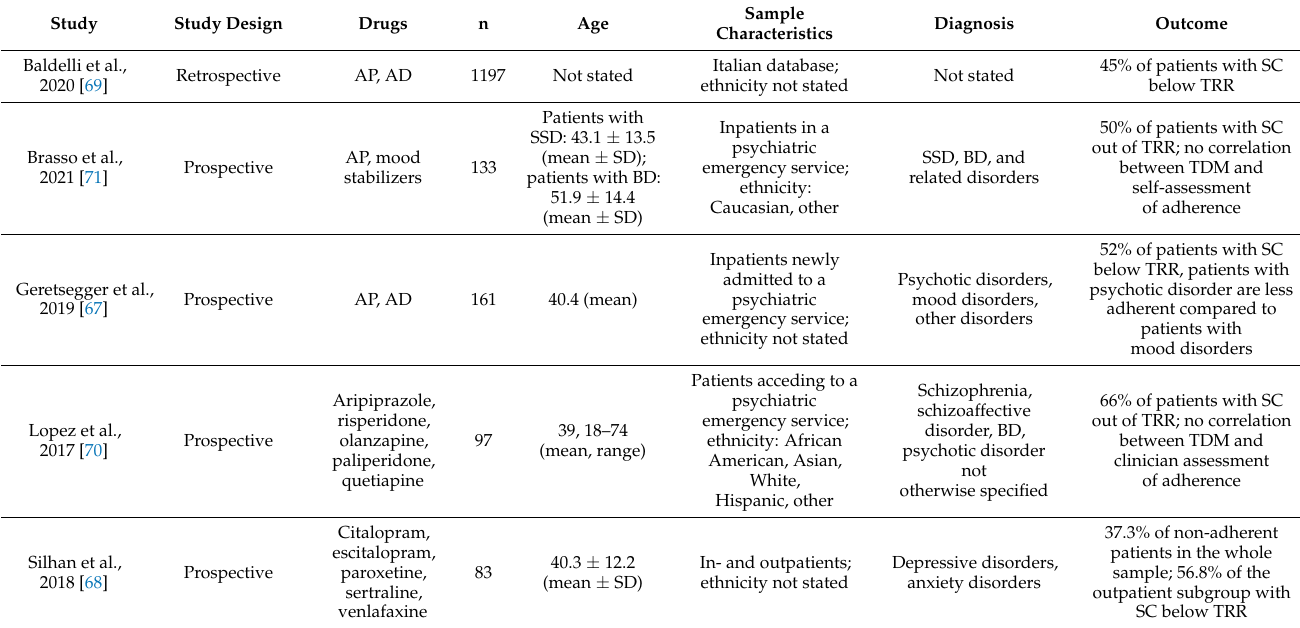
Table 4. Original articles on the use of TDM to ensure treatment